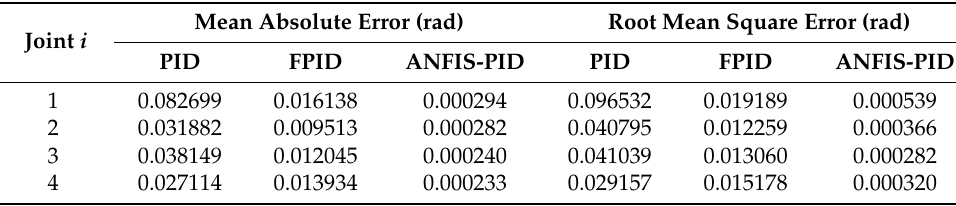
Table 1. Mean absolute error and root mean square error of trajectory tracking for each joint. Joint